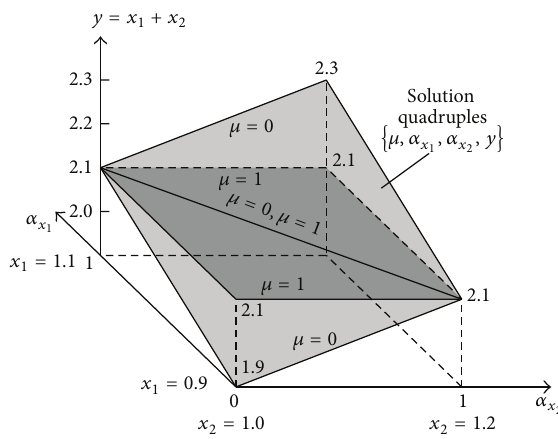
Figure 8: Multidimensional granule of the addition result of two fuzzy numbers “about 1.0” and “about 1.1” being the set of ,𝛼 , 𝑦} determinedbyformula(35)andprojected quadruples {𝜇,𝛼 𝑥 𝑥 2 1 × 𝛼 × 𝑌 . onto the 3D space 𝛼 𝑥 𝑥 2 1